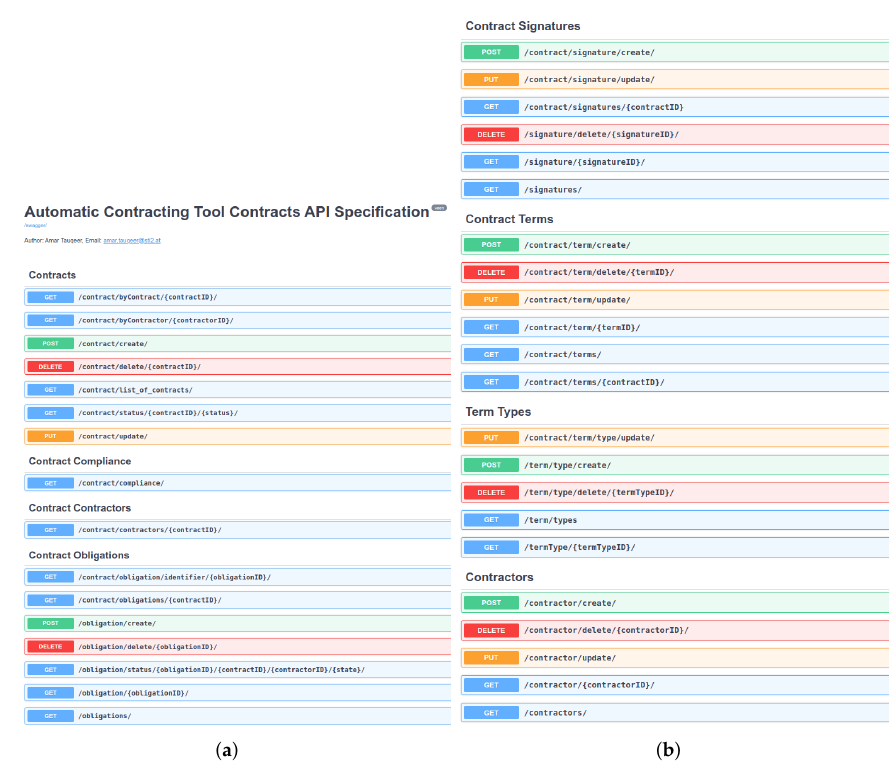
Figure 7. Contract REST API’s endpoints in Swagger. ( a ) Part 1. ( b ) Part 2.